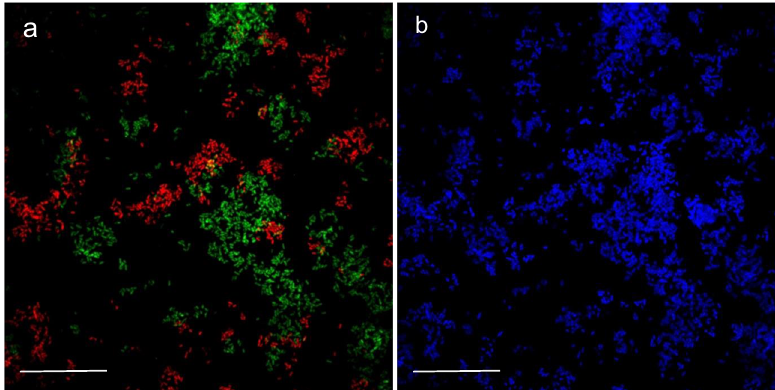
Fig. 5 Representative FISH image of D. acetexigens (green) and G. sulfurreducens (red). a Cells extracted from the anode bio fi lm of a co- culture MEC reactor fed with glucose-supplemented domestic wastewater (MEC co-culture-WW-N2 ). b Total bacterial cells stained with DAPI (blue). The sample was collected after 360 h of reactor operation. Scale bar on images a and b is 25 µm.